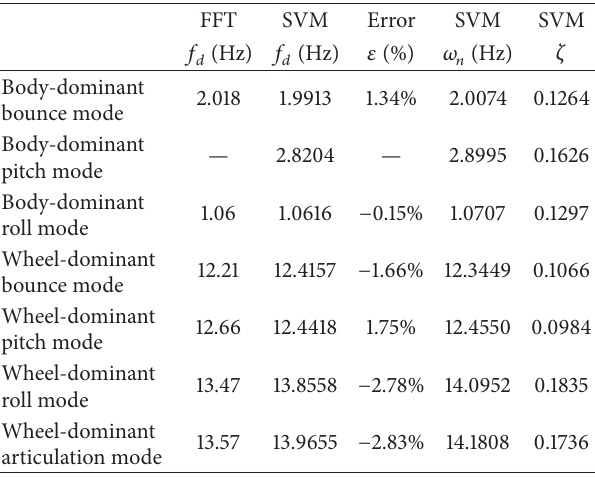
Figure 6: The FFT results of the roll angle acceleration in the roll test. Table 3: The estimated vehicle modal parameters.